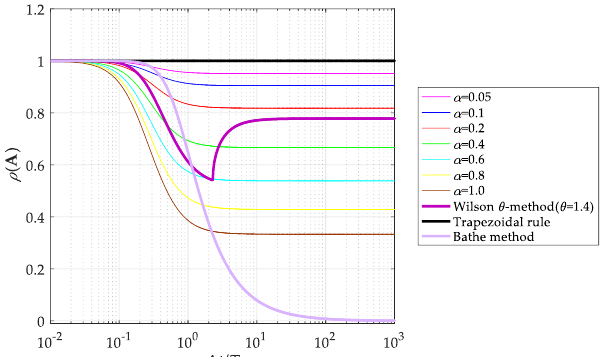
Figure 3. The spectral radii of transfer matrix A of the trapezoidal rule, Wilson θ -method, and Bathe method and the proposed scheme with different numerical damping.